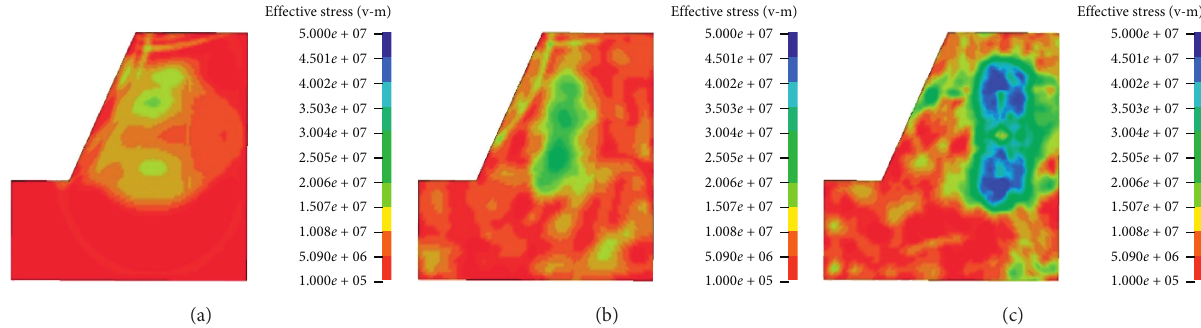
Figure 10: 13m × 6m effective stress of the section between the front holes at different times. (a) t � 1.99 ms. (b) t � 43.49ms. (c) t �